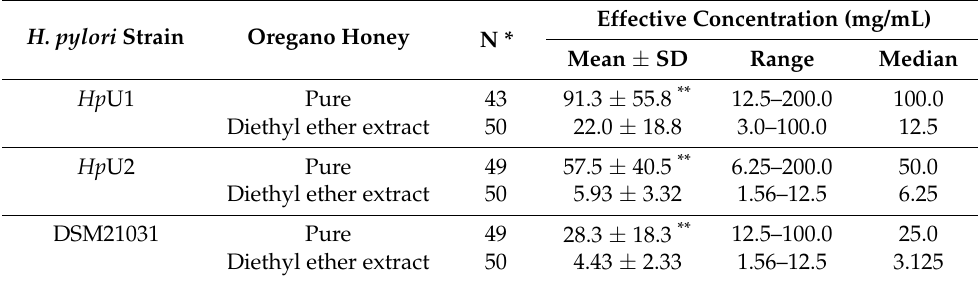
Table 5. Urease Inhibitory effect of pure and diethyl ether extracts of oregano honey against two H. pylori strains isolated from ulcers ( Hp U1, Hp U2) and the reference strain DSM21031. H. pylori